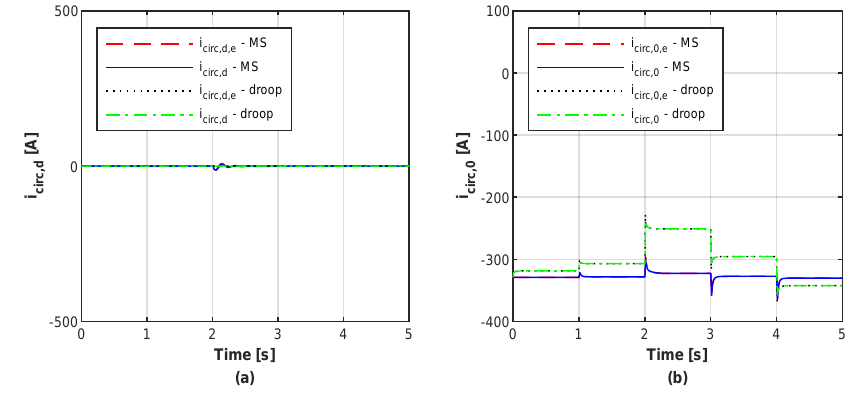
Figure 18. Circulating current response from terminal 3: ( a ) i circ , d ; ( b ) i circ ,0